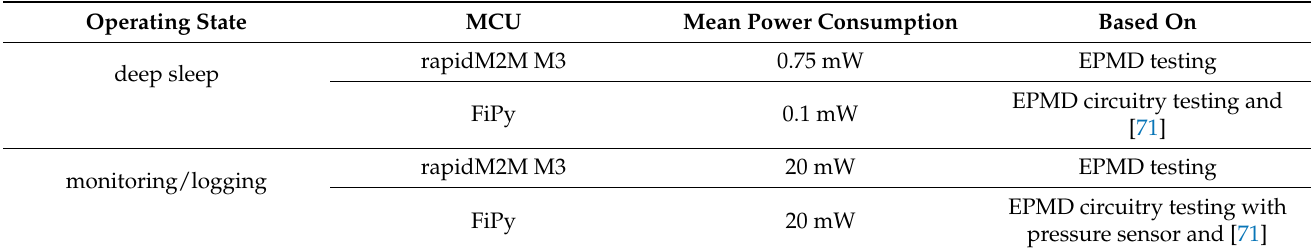
Table 4. Energy consumption during deep sleep and